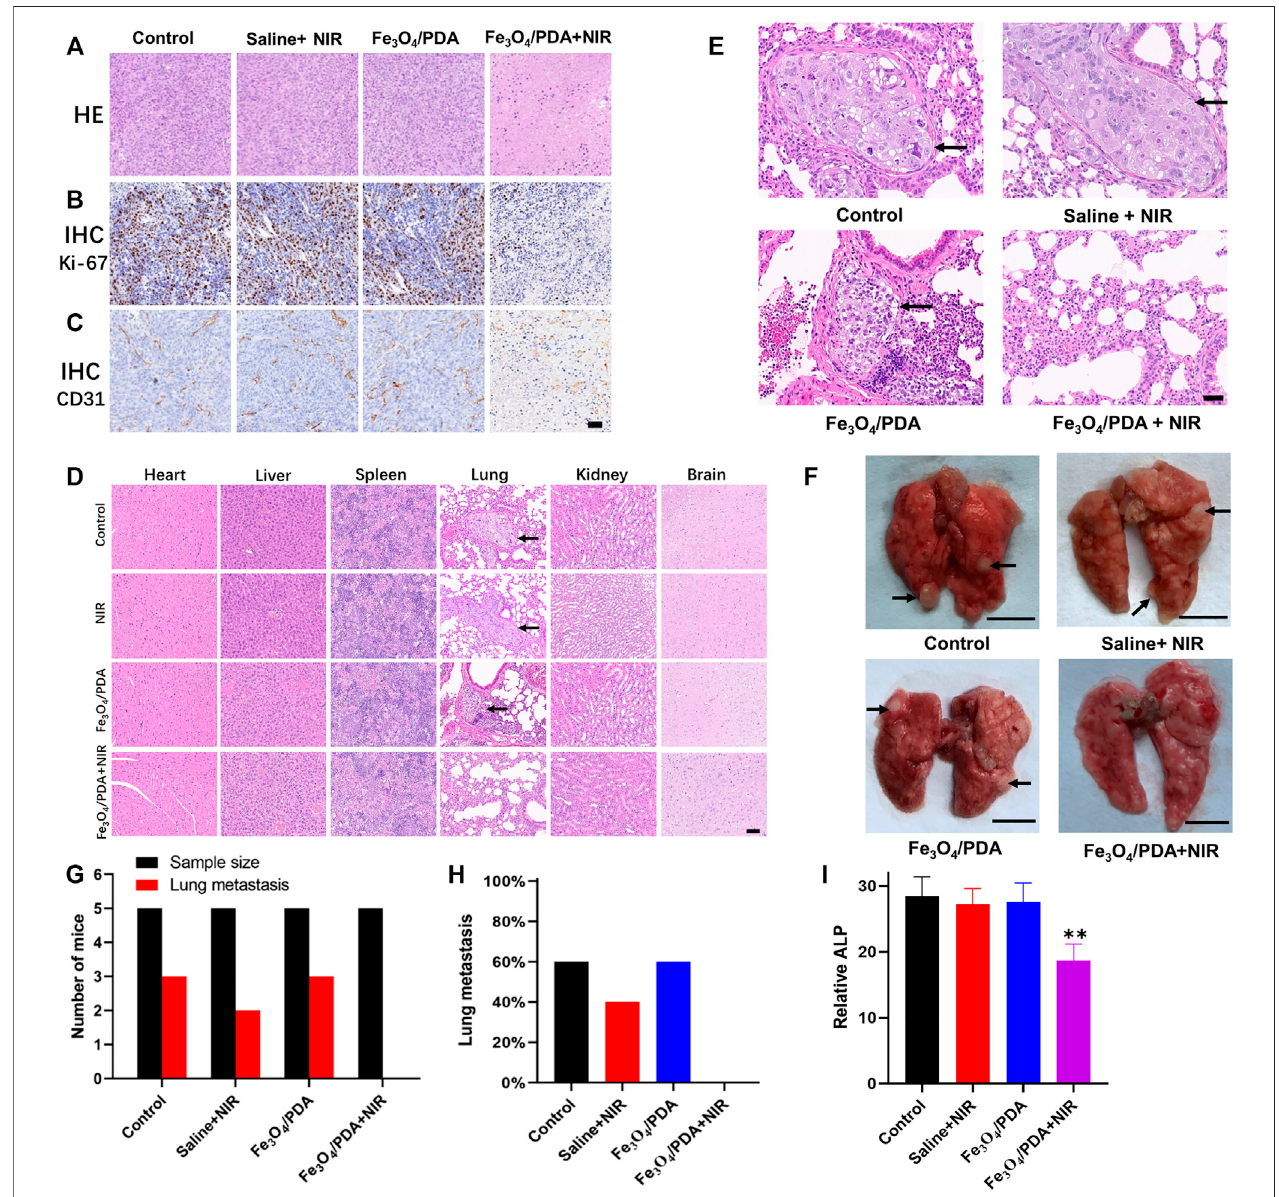
FIGURE 7 | (A) Orthotopic tumors from mice in the indicated treatment groups were collected after 3 weeks and subjected to H&E staining (Scale bar: 100 μ m). Tumors were additionally subjected to IHC staining for (B) Ki-67 and (C) CD31. (D) Major organs from mice in the indicated treatment groups were subjected to H&E staining,revealinglungmetastasesinthe fi rstthreegroups(Scalebar:100 μ m). (E) H&Estainingoflungtissuesectionsfromtumor-bearingmicerevealedanabsenceof metastases in the Fe 3 O 4 @PDA+NIR group (Scale bar: 50 μ m). (F) Pulmonary metastases (arrows) in the lungs of OS tumor-bearing mice (Scale bar: 5 mm) (G) Numbersoflungmetastases intheindicatedgroups. (H) theproportionofmice exhibitinglungmetastasesintheindicatedgroups. (I)